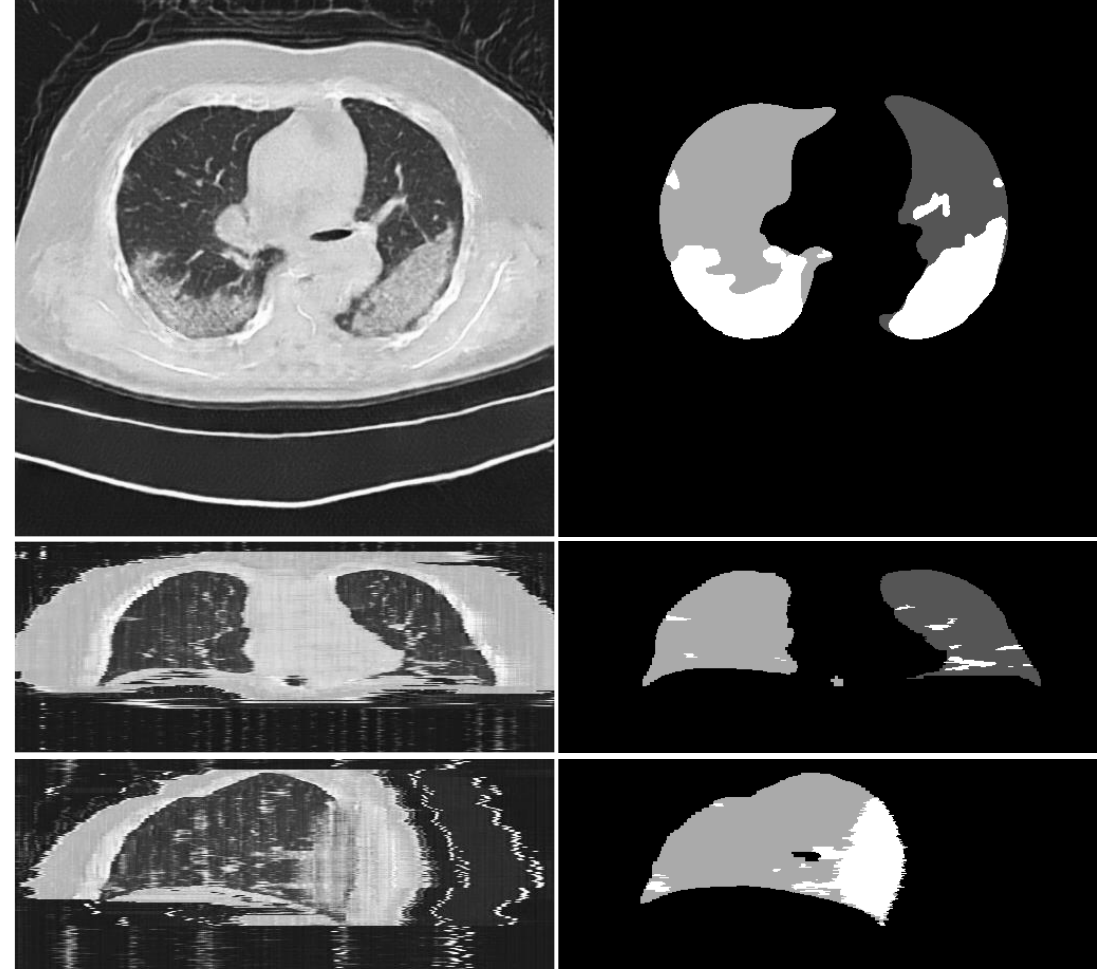
Figure 14. Illustration of the axial, coronal, and sagittal views of a synthetic CT volume. The white and gray (e.g., light gray and dark gray) in condition masks represent the infected regions and lungs,